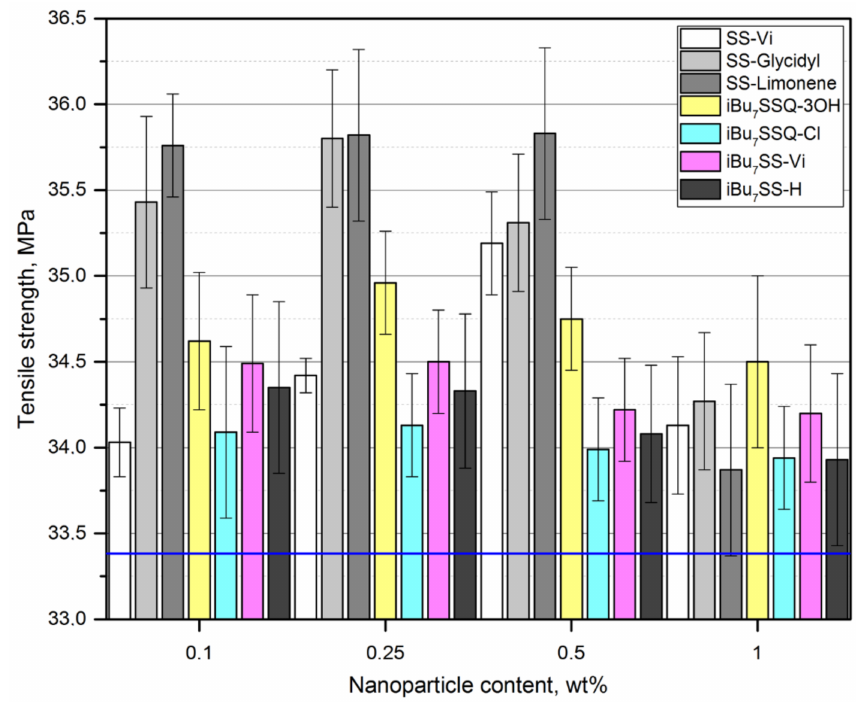
Figure 6. Tensile strength of the CS/iPP composites.